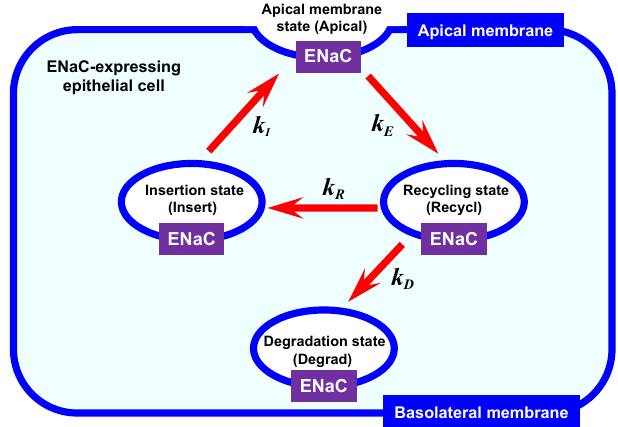
Figure 1. An intracellular ENaC tra ffi cking model. (1) An insertion state (Insert): this state contains epithelial Na + channel (ENaC) that accesses to the apical membrane with an insertion rate into the apical membrane ( k I ). (2) An apical membrane state (Apical): this state contains ENaC that functions as Na + -conducting (permeant) pathways across the apical membrane. (3) A recycling state (Recycl): this state contains ENaC retrieved from the apical membrane with an endocytotic rate ( k E ), and then the ENaC is tra ffi cked back to the insertion state (Insert) with a recycling rate ( k R ), or moves to a degradation pathway (Degrad) with a degradation rate ( k D